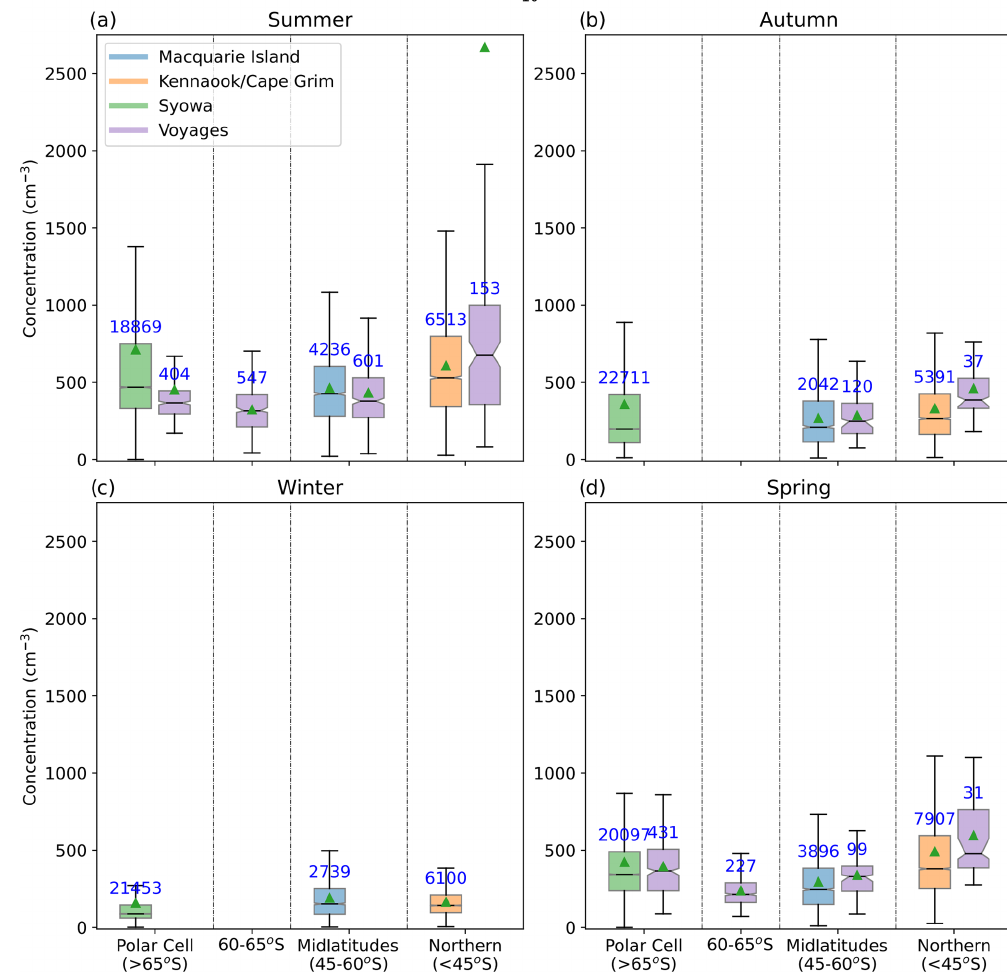
https://doi.org/10.5194/acp-23-3749-2023 Atmos. Chem. Phys., 23, 3749–3777,